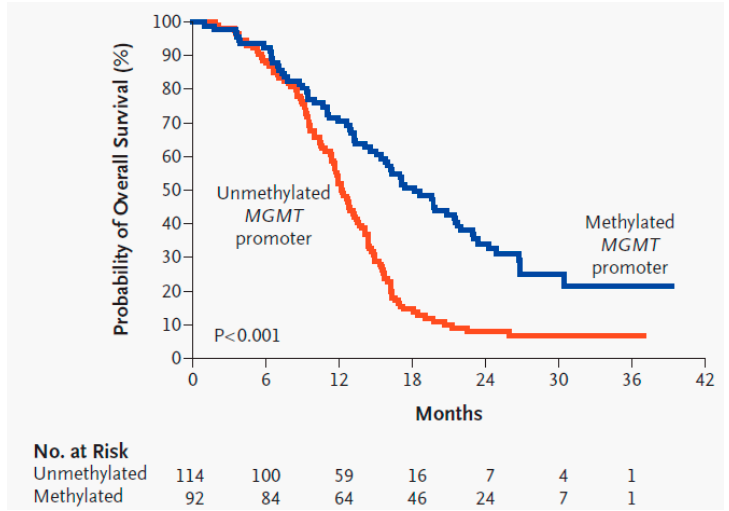
Figure 4. Kaplan–Meier estimates of overall survival of glioblastoma patients with a methylated MGMT promoter compared to an unmethylated MGMT promoter [16]. Used with permission.